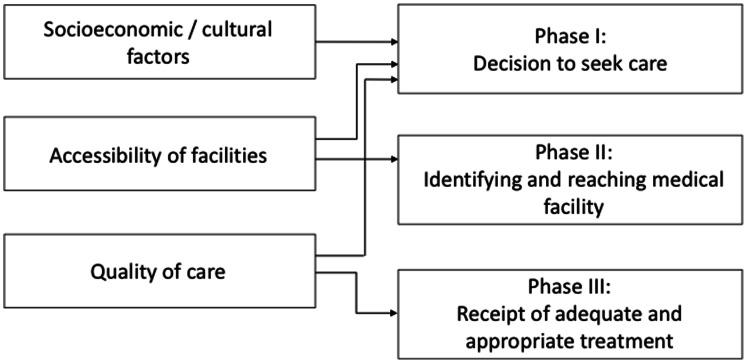
Three Delays Model.